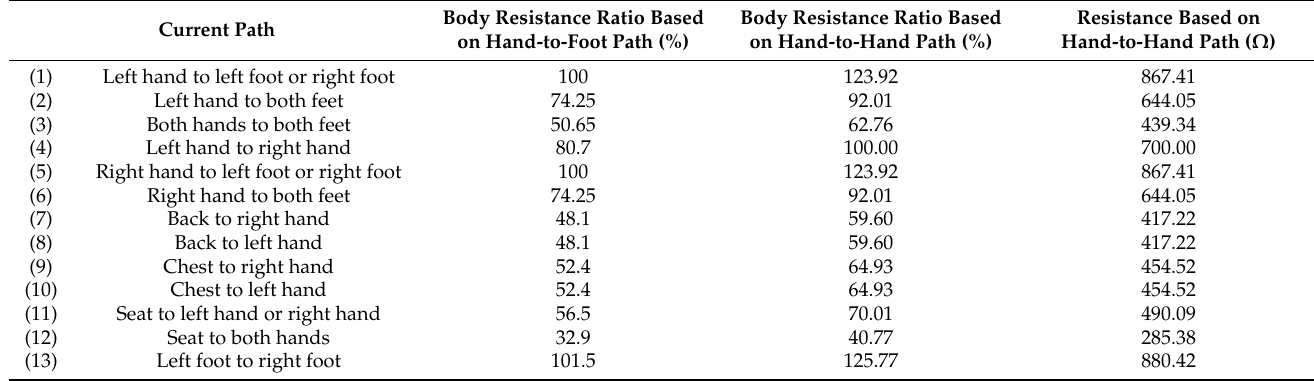
Table 6. Ratio of the body resistance and body resistance according to the current path.